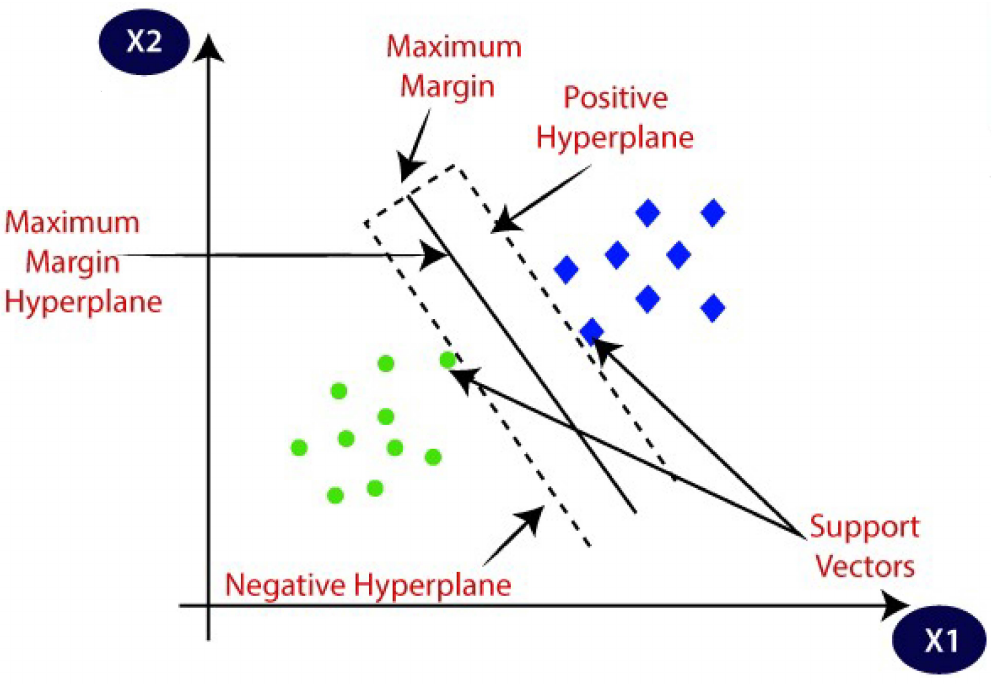
Figure 2. Hyperplane supporter in SVM plan.